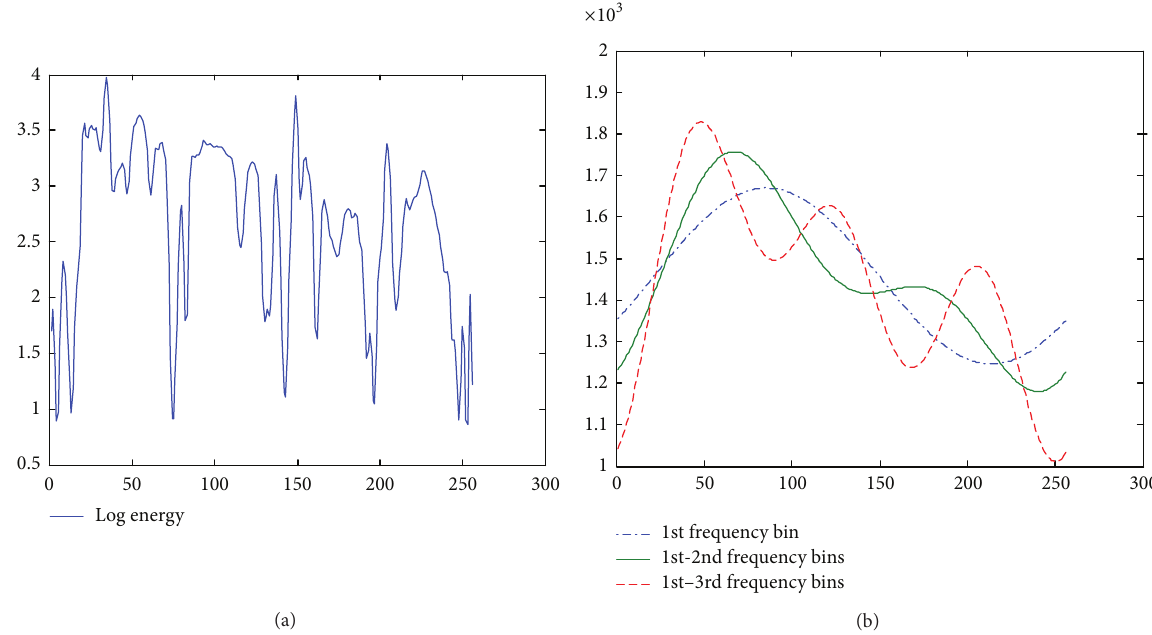
Figure 5: Examples of approximated LFE energy contours from a sad speech utterance.